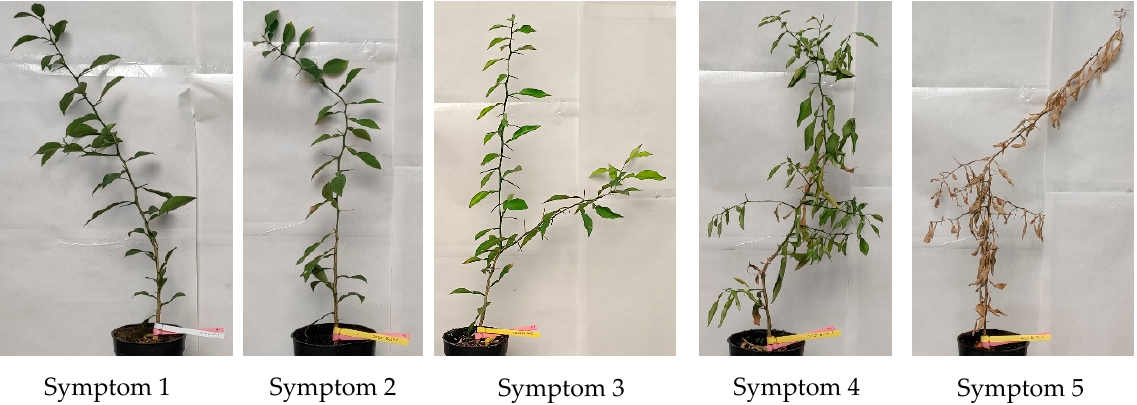
Figure 2. Disease index with a symptom scale of 1–5: 1, healthy plant; 2, first signs of leaf decline and chlorosis on plant; 3, plant with chlorotic and curly leaves; 4, wilted plant with first symptoms of leaf desiccation; and 5, dead plant.